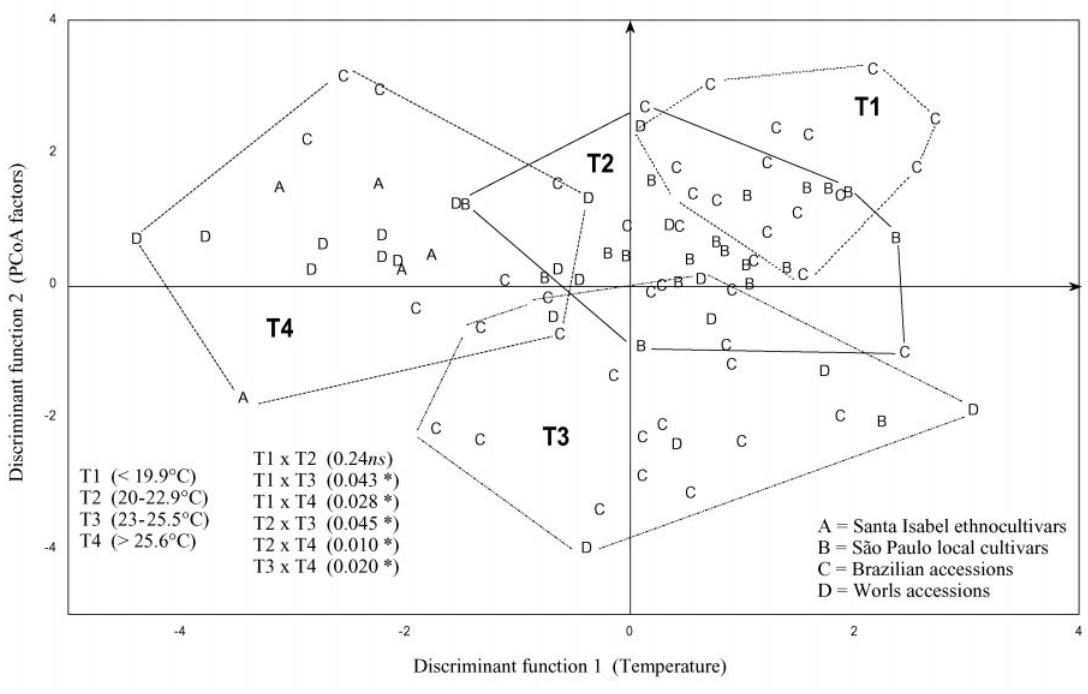
Figure 6 - Scattering of 90 cassava cultivars on a plot defined by discriminant function 1, based on temperature (T1 to T3) of cultivar’s place of origin, and discriminant function 2, based on the first 40 principal coordinate analysis (PcoA) factors. ns, Nonsignificant. *Statistically signifi- cant at